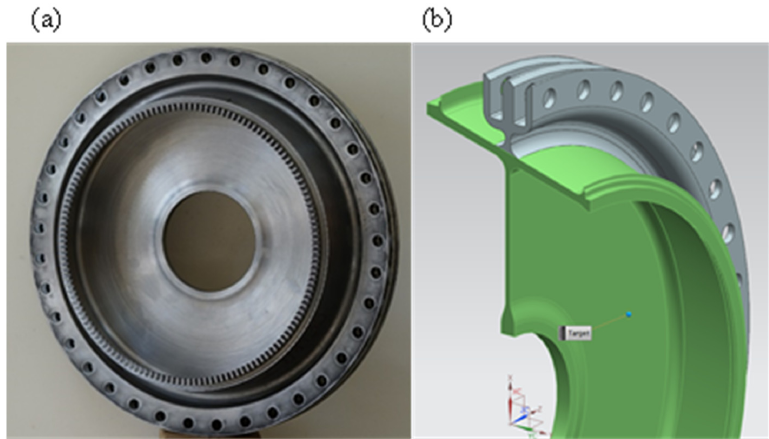
Figure 1. Optimised compressor disc: ( a ) real object, ( b ) CAD